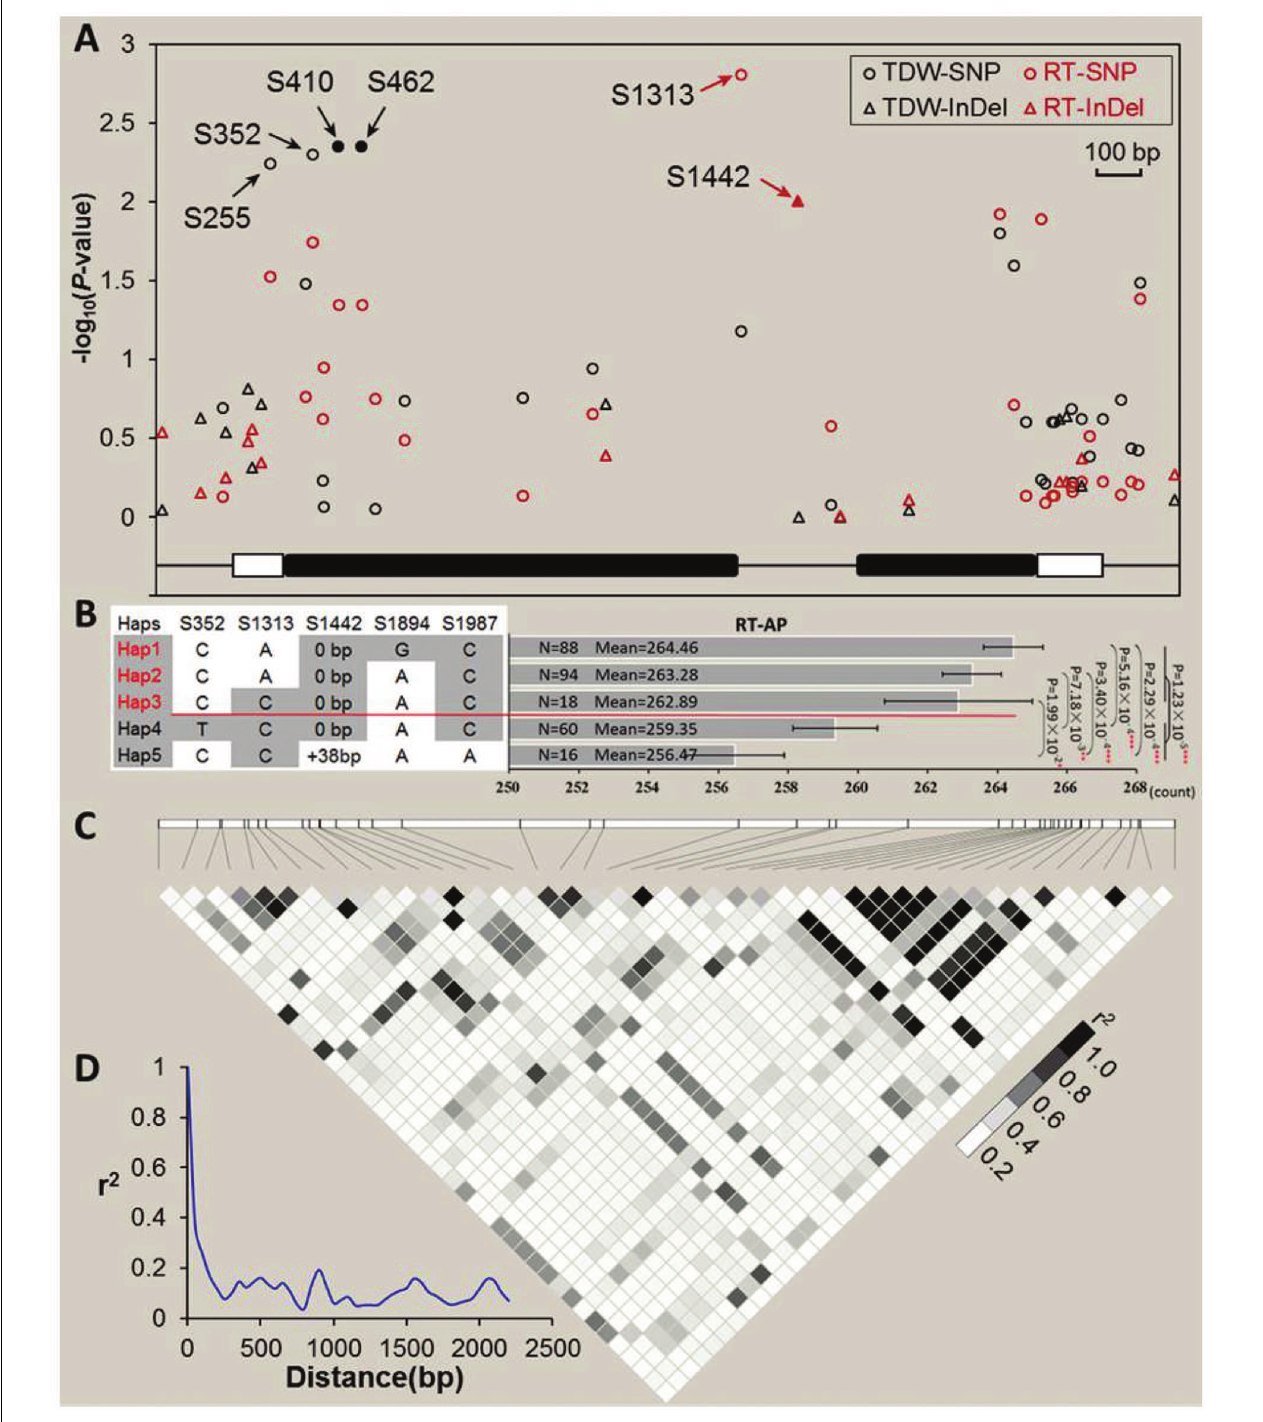
FIGURE 3 | Natural variation and haplotype within ZmARF31 are associated with P-deficiency-tolerance traits. (A) Natural variation in ZmARF31 associated with total dry weight (TDW) and root tips (RT) under P-applied condition. Each circle and triangle represents a polymorphic SNP and InDel site, respectively. The P value is shown on a − log 10 scale. A schematic diagram of the entire gene structure is presented as the x -axis, including white and black boxes showing as UTRs and exons, respectively. (B) Effect of haplotypes consisting of five significant loci on RT in 331 maize inbreds. Hap, haplotype; Hap1–Hap5 with MAF ≥ 0.05 were used for the statistic test. (C) The pattern of pairwise LD of DNA polymorphisms (MAF ≥ 0.05) in ZmARF31 . The shaded color reflects the level of LD ( r 2 ). (D) LD decay in the DNA sequence of ZmARF31 in maize. Measurement was performed by averaging r 2 values of allele frequencies over a distance of 100 bp and plotting the values against distance